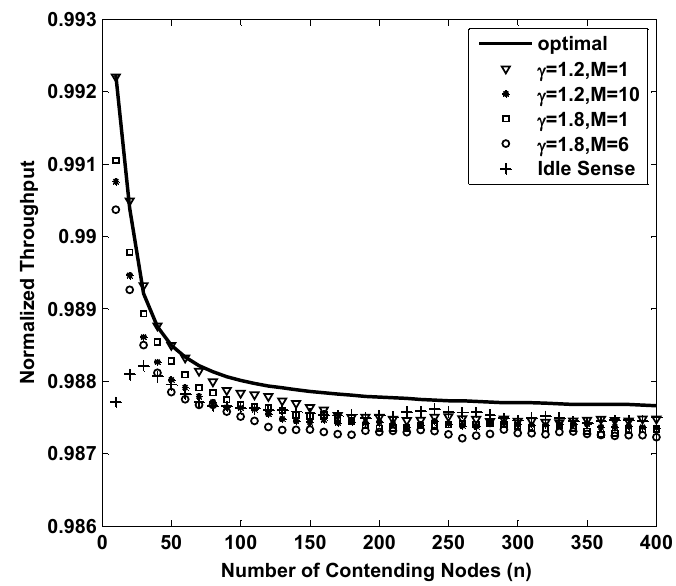
Figure 5. The normalized throughput performance of M -level contention window tuning algorithm with different M and γ and idle sense algorithm for super dense deployed networks.